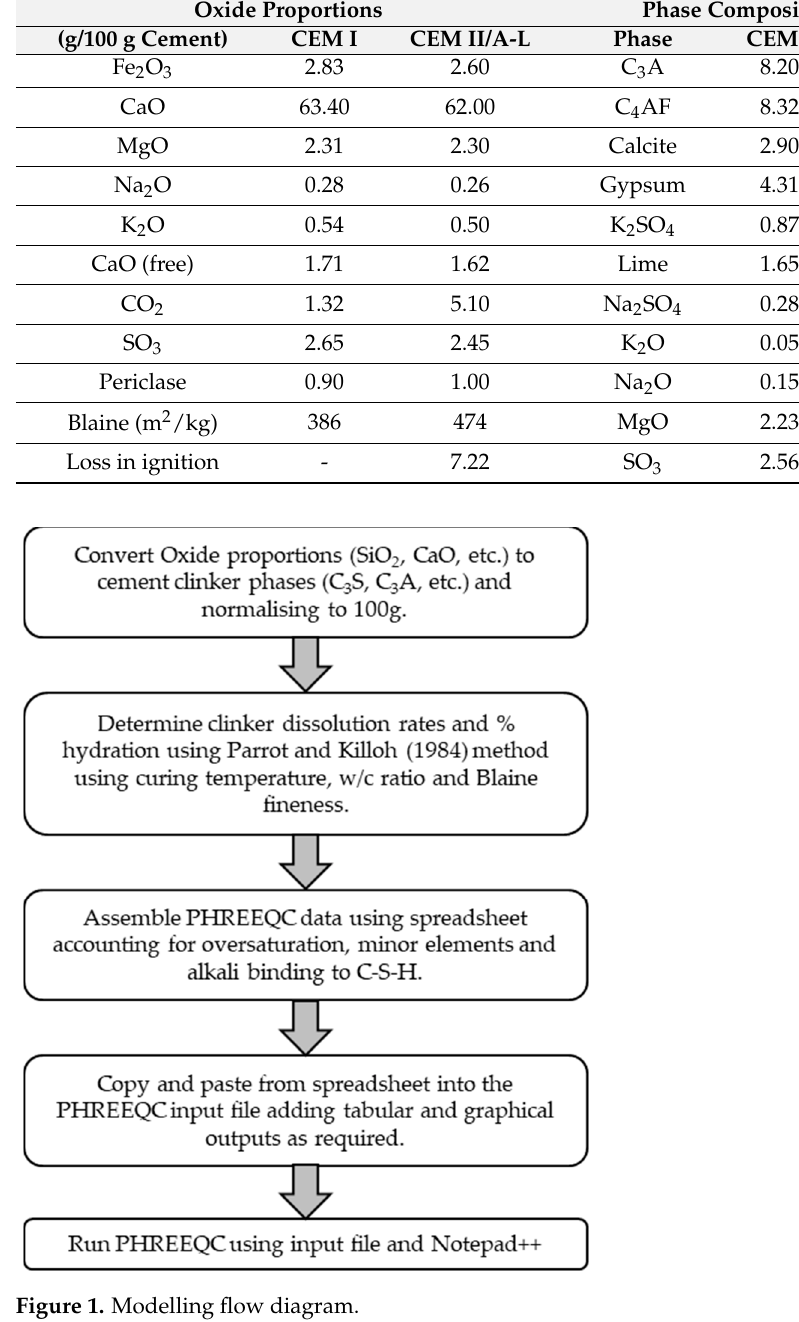
Figure 1. Modelling flow